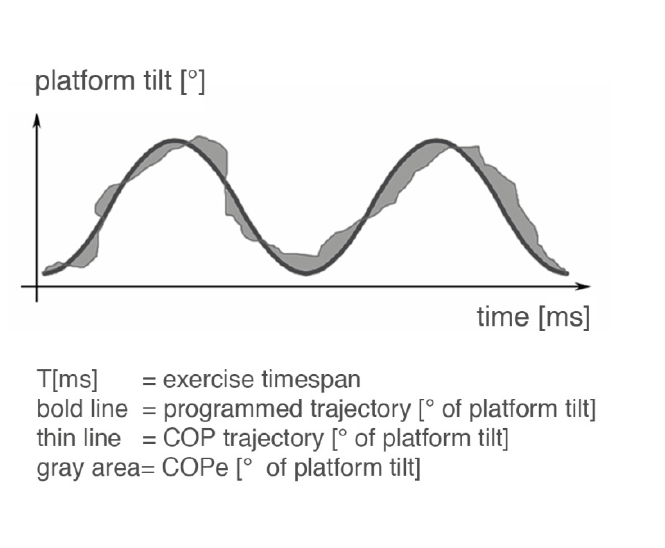
Figure 3. Center of pressure error (COPe). The COPe [°] is calculated from the deviation between the person’s effective actual COP trajectory and the programmed trajectory in the given exercise time span. A maximum 24° of erroneous tilt of platform is